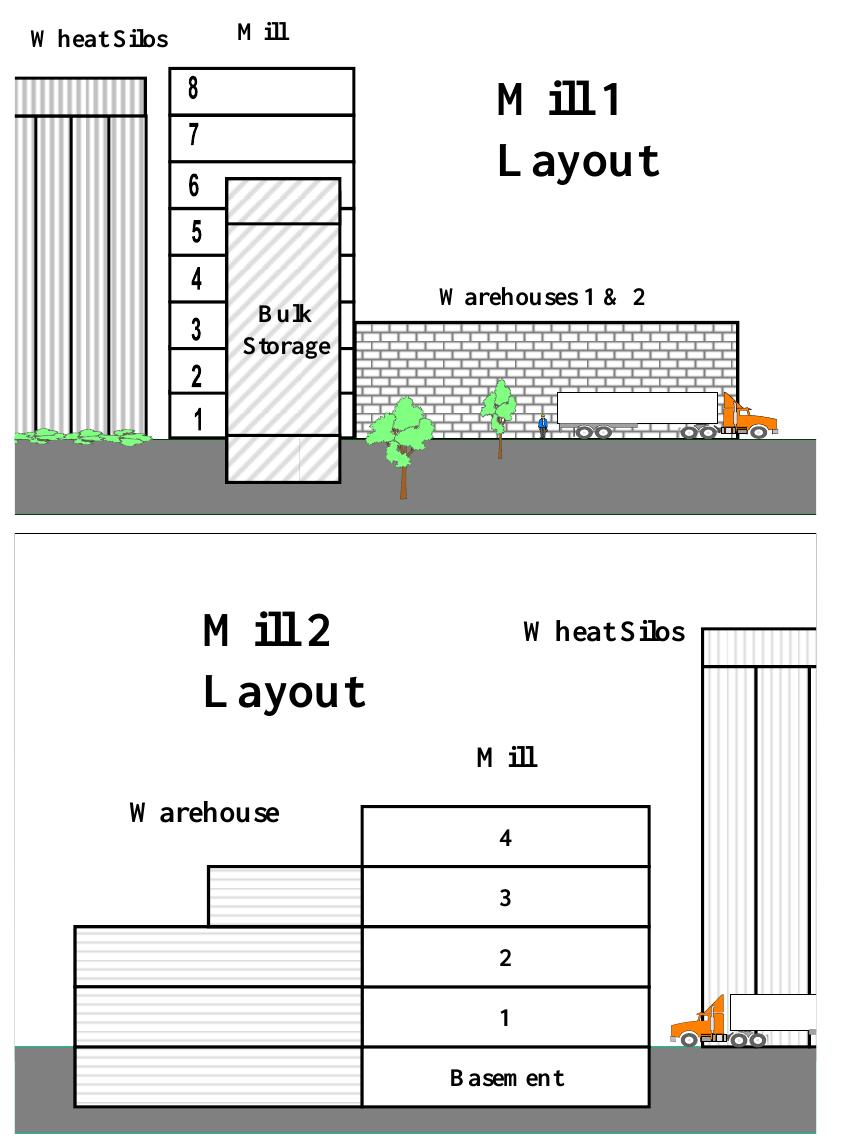
Figure 1. Layout of mills 1 & 2. Traps were deployed on floors three to eight of mill 1, in the rooms above and below the bulk flour bins, and in warehouse 1. Traps were deployed among all mill 2 floors (basement to fourth floor) and the corresponding warehouse areas of each floor (basement to third floor).